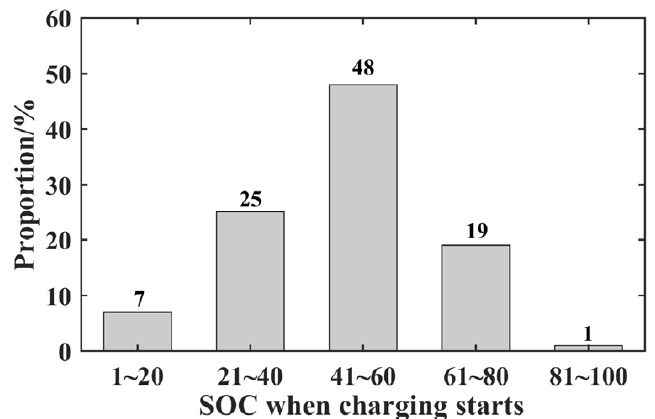
Figure 4. Classification of EV users in residential areas.